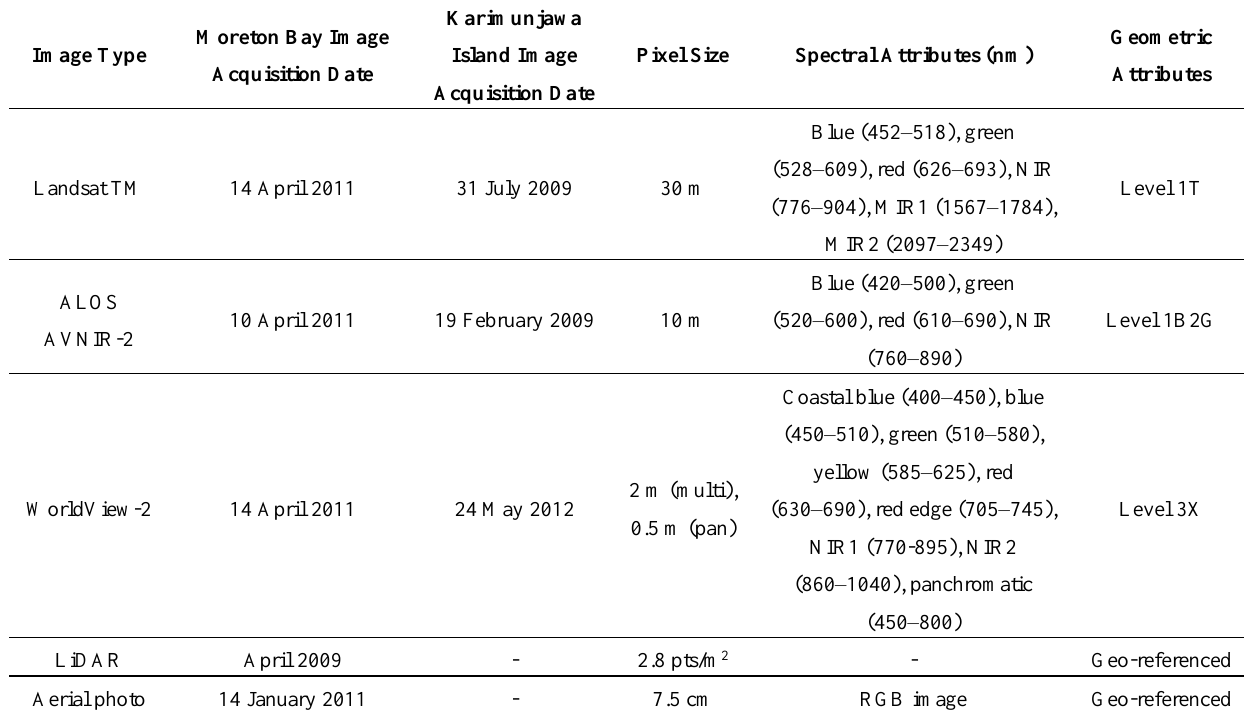
Table 1. Image datasets used in this